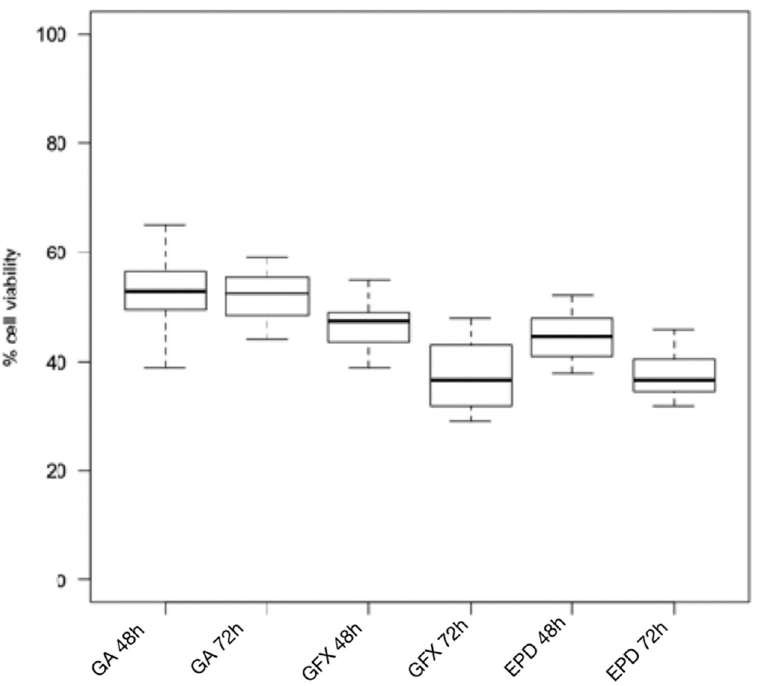
Figure 2. Cytotoxicity of composite resins on human gingival fibroblast cell lines after 24 h and 48 h. GA: G-ænial (Anterior); GFX: G-ænial Flo X; EPD: Enamel Plus HRi Bio Function Bio Dentine.